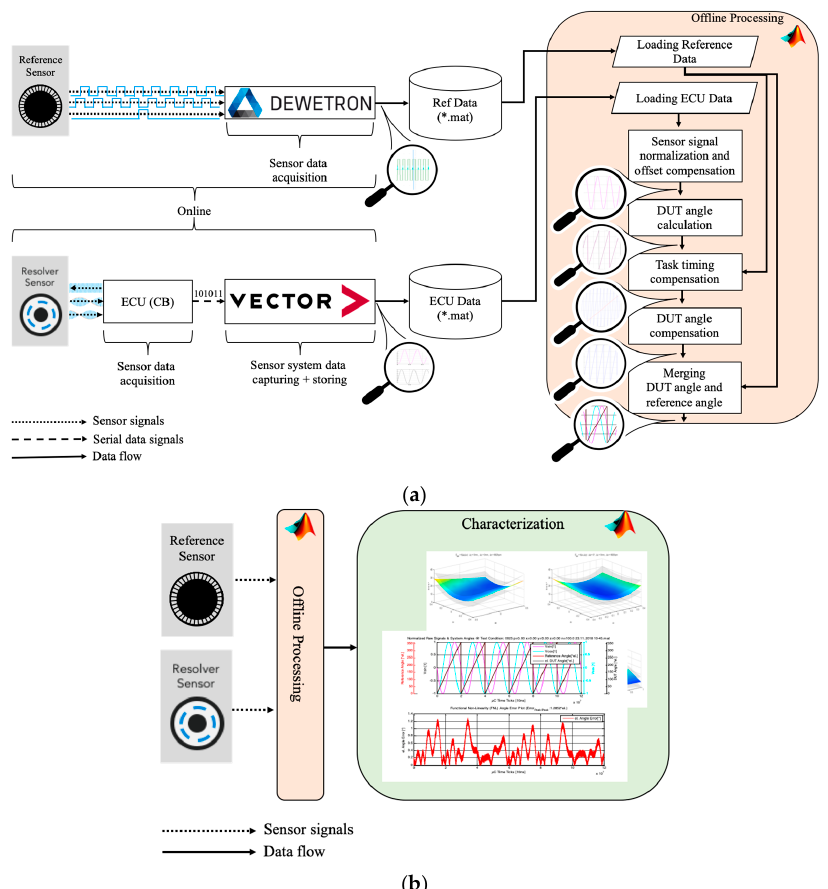
Figure 13. Overview of the measurement process. ( a ) Readout of the sensor data including sensor data acquisition, capturing and storing (online). The figure also illustrates the information flow and the developed offline sensor data post processing algorithm. ( b ) Further potential offline characterization after the offline processing